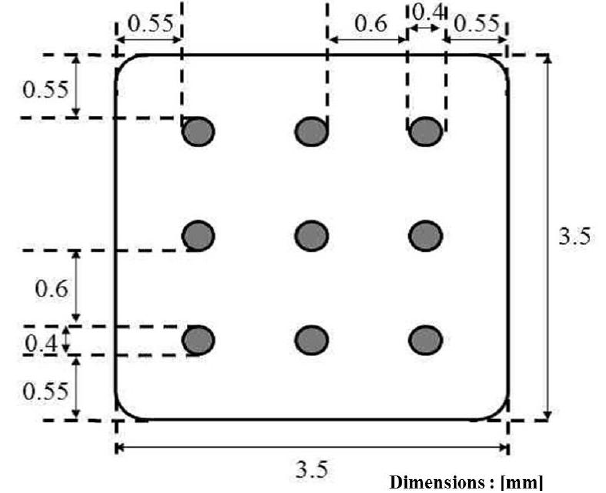
Figure 1. Dimensions of the microelectrode